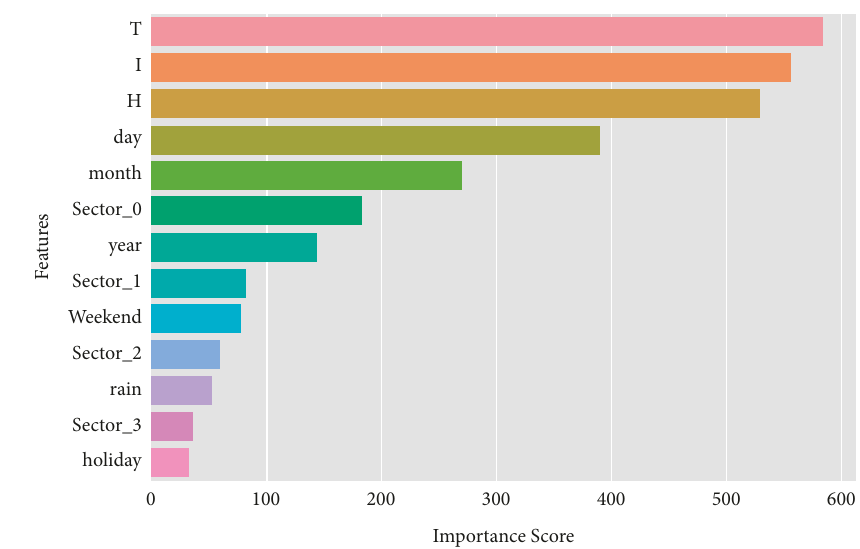
Figure 11: Feature importance